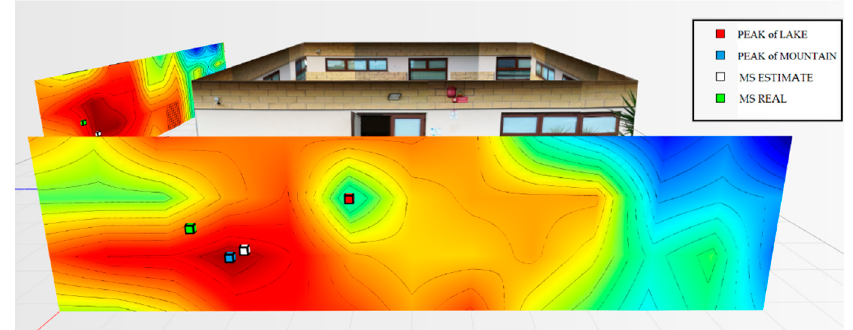
Figure 25. Power levels for wall 2 relative to the terminal located in the room on the left at 1.5 m.